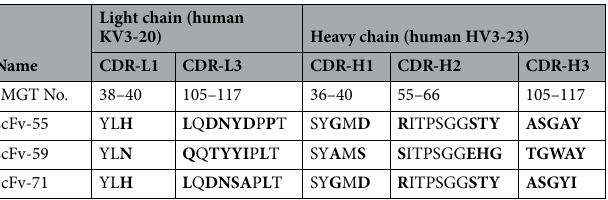
Table 1. Variable heavy and light chain single clone sequences of scFv-55, scFv-59, and scFv-71. Positions with differences present are marked